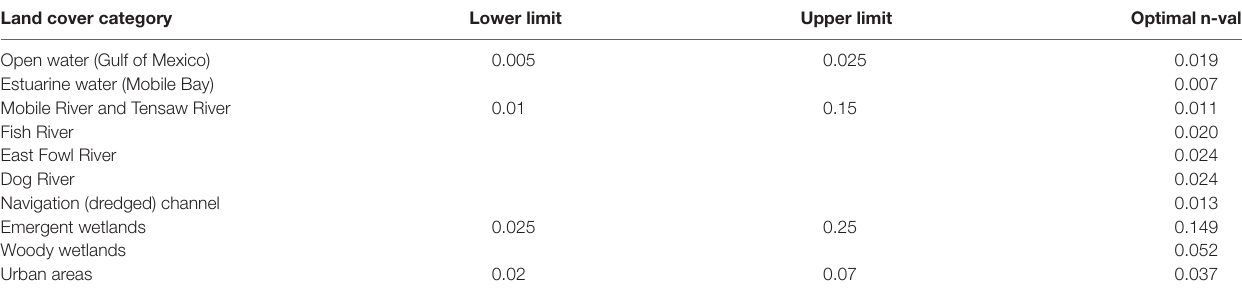
TABLE 1 | Range of Manning’s roughness values used for calibration of the Mobile Bay